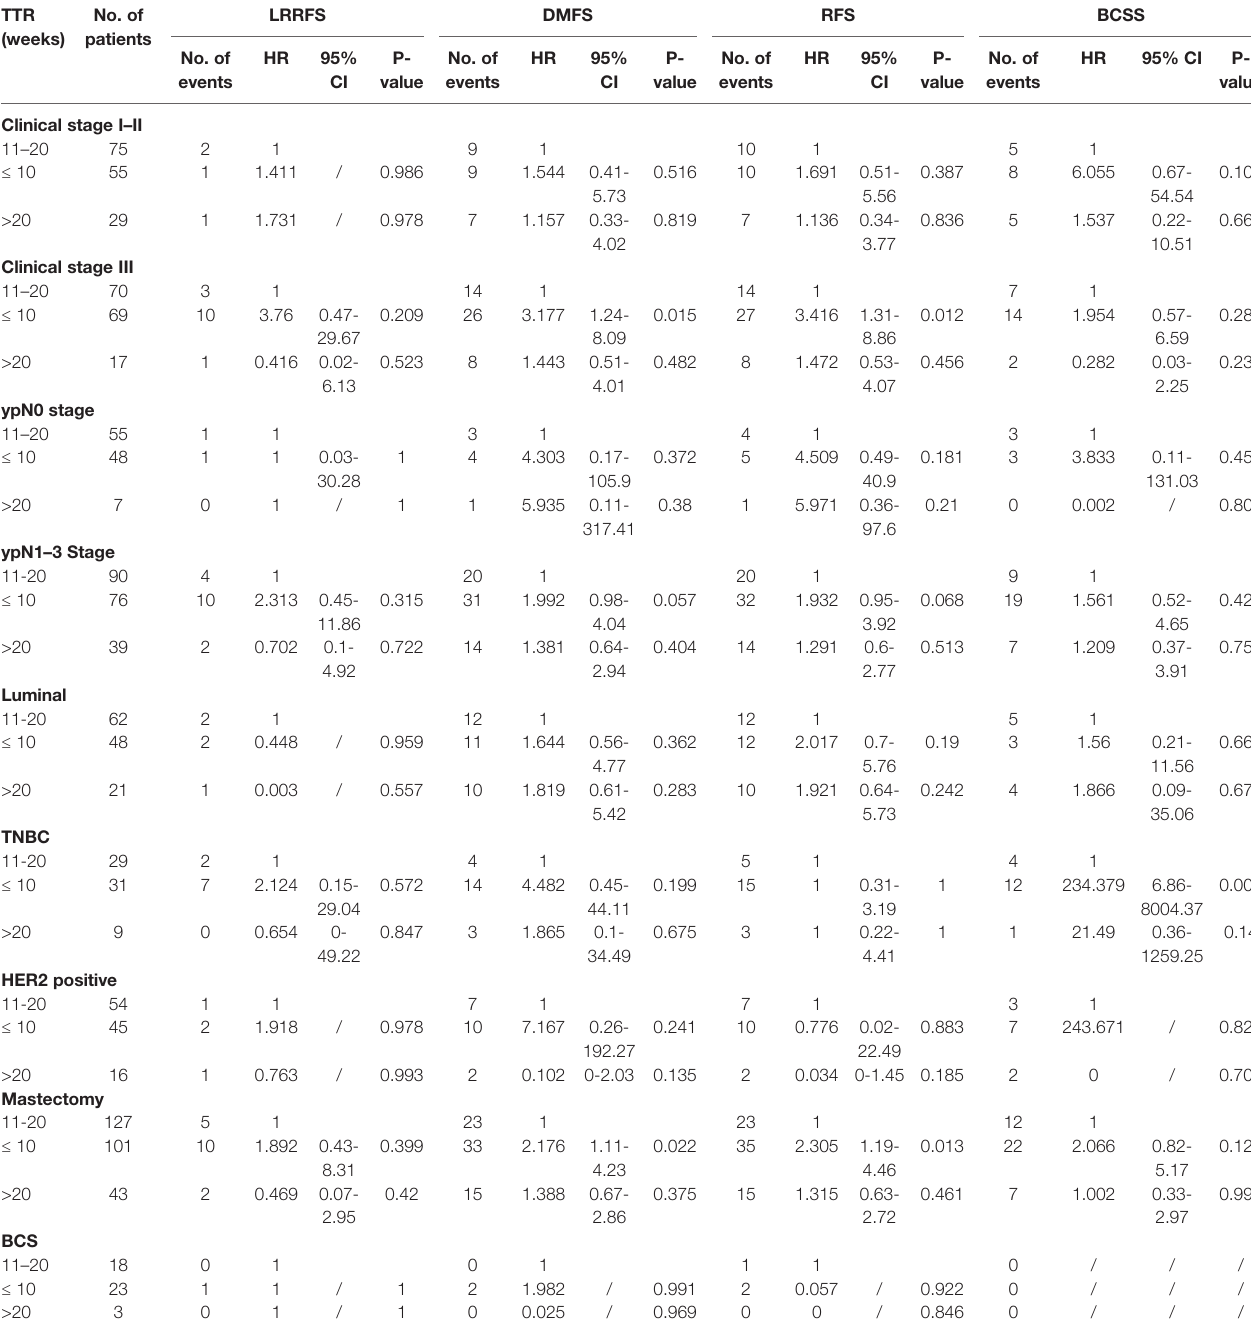
TABLE 4 | Adjusted HR of survival outcomes by TTR in the multivariable Cox proportional hazards model, strati fi ed by the clinical stage, ypN stage, molecular subtypes, and the type of primary surgery. TTR